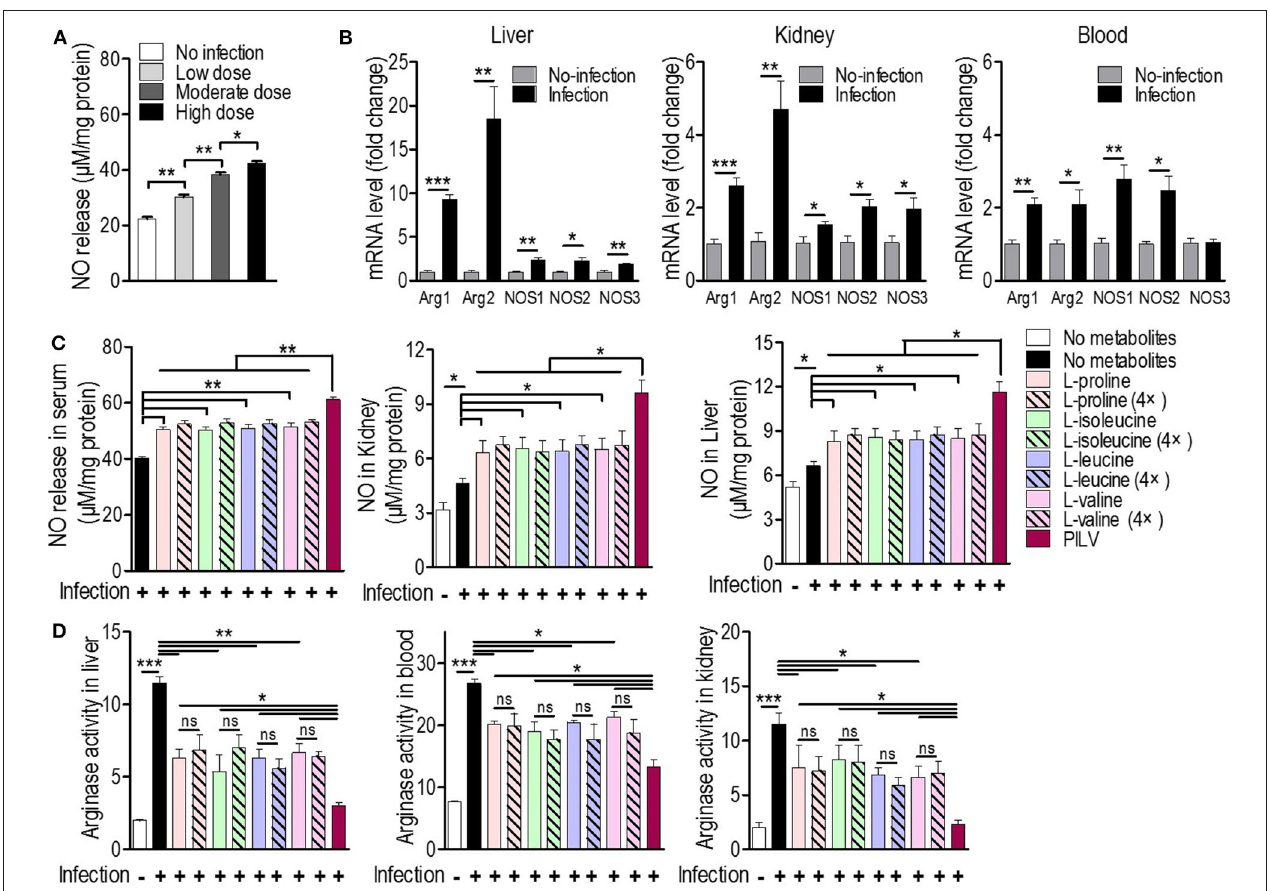
FIGURE 4 | Metabolites promote NO production by arginase inhibition in mice. (A) The NO release under three sublethal doses (0.3 × 10 7 , 0.7 × 10 7 , and 1 × 10 7 CFU/mouse) of S. aureus Newman infection ( n = 5 for each dose group). Three days post-infection, mouse serum was collected and subjected to measurement of NO release. (B) The mRNA levels of two arginase (ARG) and three NO synthase (NOS) isoforms in mouse liver, kidney, and blood under a sublethal staphylococcal infection. S. aureus USA300 (5 × 10 6 CFU/mouse) was used to infect BALB/c mice ( n = 5). Three days after the infection, the mouse liver, kidney, and blood were collected and the transcriptional expression of ARG and NOS was measured. Arg1 and Arg2 are cytoplasmic and mitochondrial arginases, respectively. Nos1 , Nos2 , and Nos3 are neuronal, inducible, and endothelial NOS, respectively. The NO production (C) and arginase activity (D) in mouse blood and tissues treated with single metabolite or PILV under staphylococcal infection. Data are represented as means ± SEM. * P < 0.05, ** P < 0.01 and *** P < 0.001 (two-tailed Student’s t